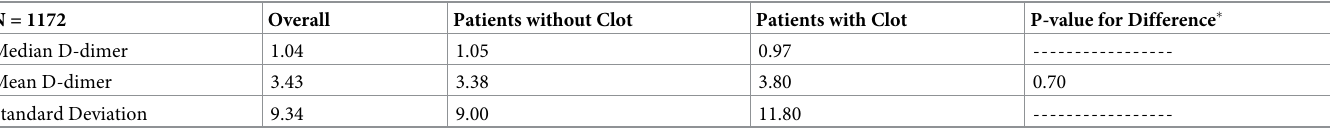
Table 5. Comparison of D-dimer levels in the first 48 hours of hospitalization between those with and without thrombosis admitted to the general hospital floors. N = 1172